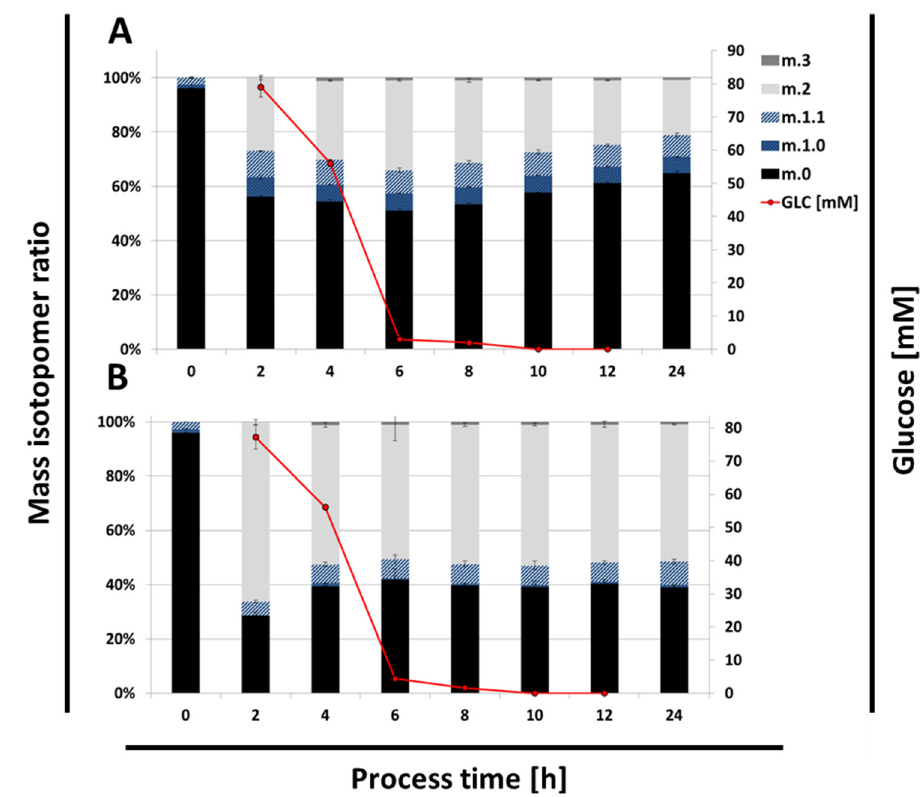
Figure 4. Mass isotopomer proportions of the 13 C labeling states of alanine for ( A ) Δ upp and ( B ) Δ gnd mutant strains. The process time indicates the sampling points; the red line indicates the respective glucose concentration. The isotopic state of alanine can be unlabeled (m.0, black), single (m.1.0 blue dotted, m.1.1 blue dashed), double (m.2, grey), or triple (m.3, dark grey) 13 C labeled. Mean values and standard deviations of at least two replicates are